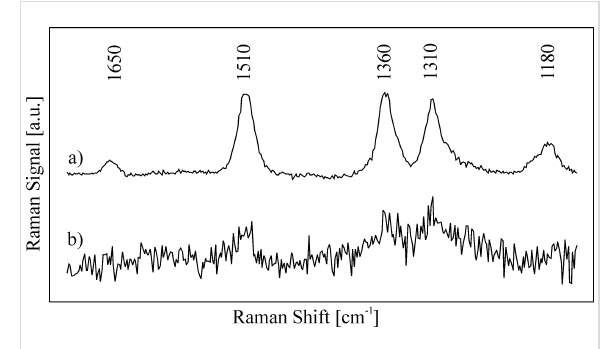
Figure 7: SERS spectra collected from a 10 nL probed volume at concentrations of 10 − 15 and 10 − 12 M of rhodamine 6G in an aqueous solution of silver nanoaggregates, excitation at 830